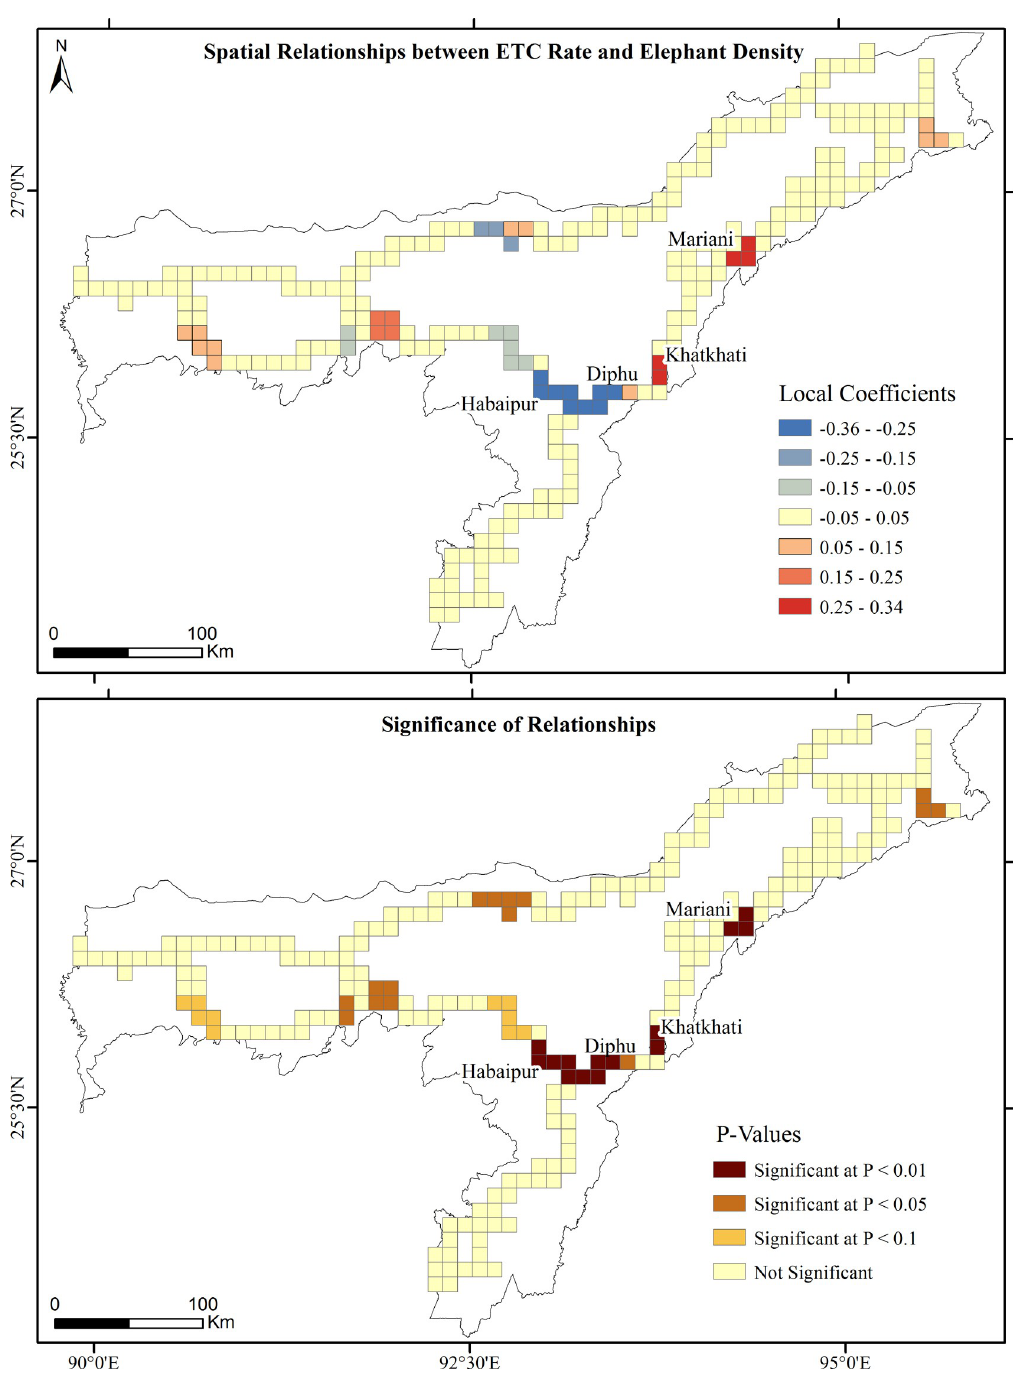
Fig 9. Local coefficients and P-values of GWR model for the spatial relationships between ETC rates and elephant densities. death traps for elephants because they cannot elude from those railway corridors quickly enough [83].